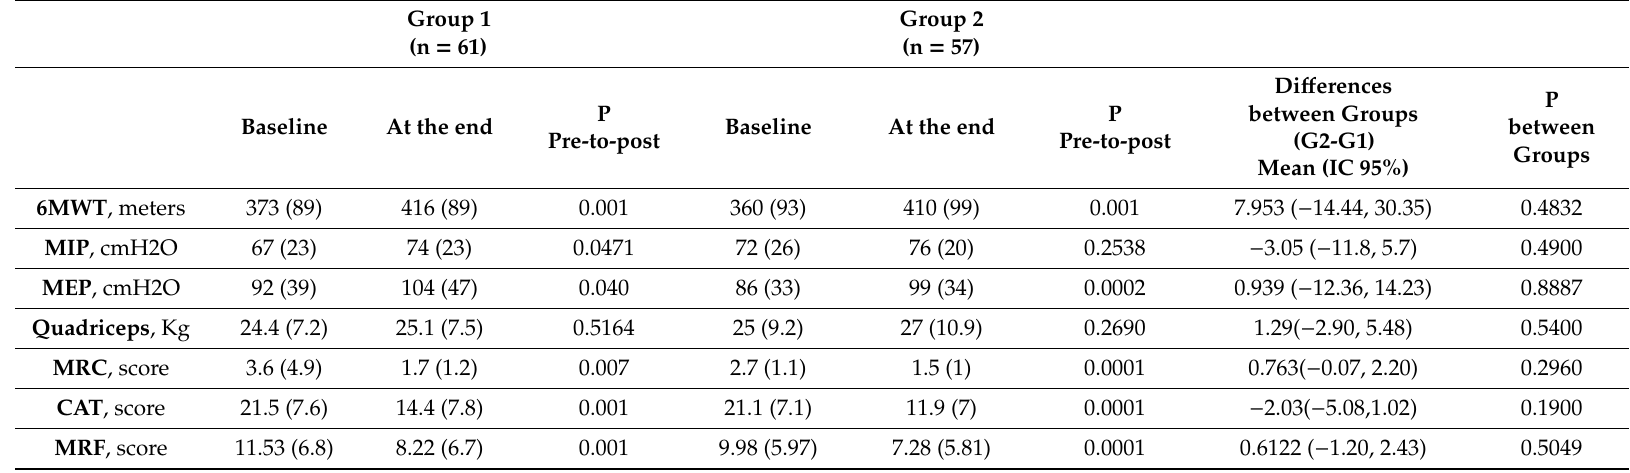
Table 2. Pre-to-post changes in secondary